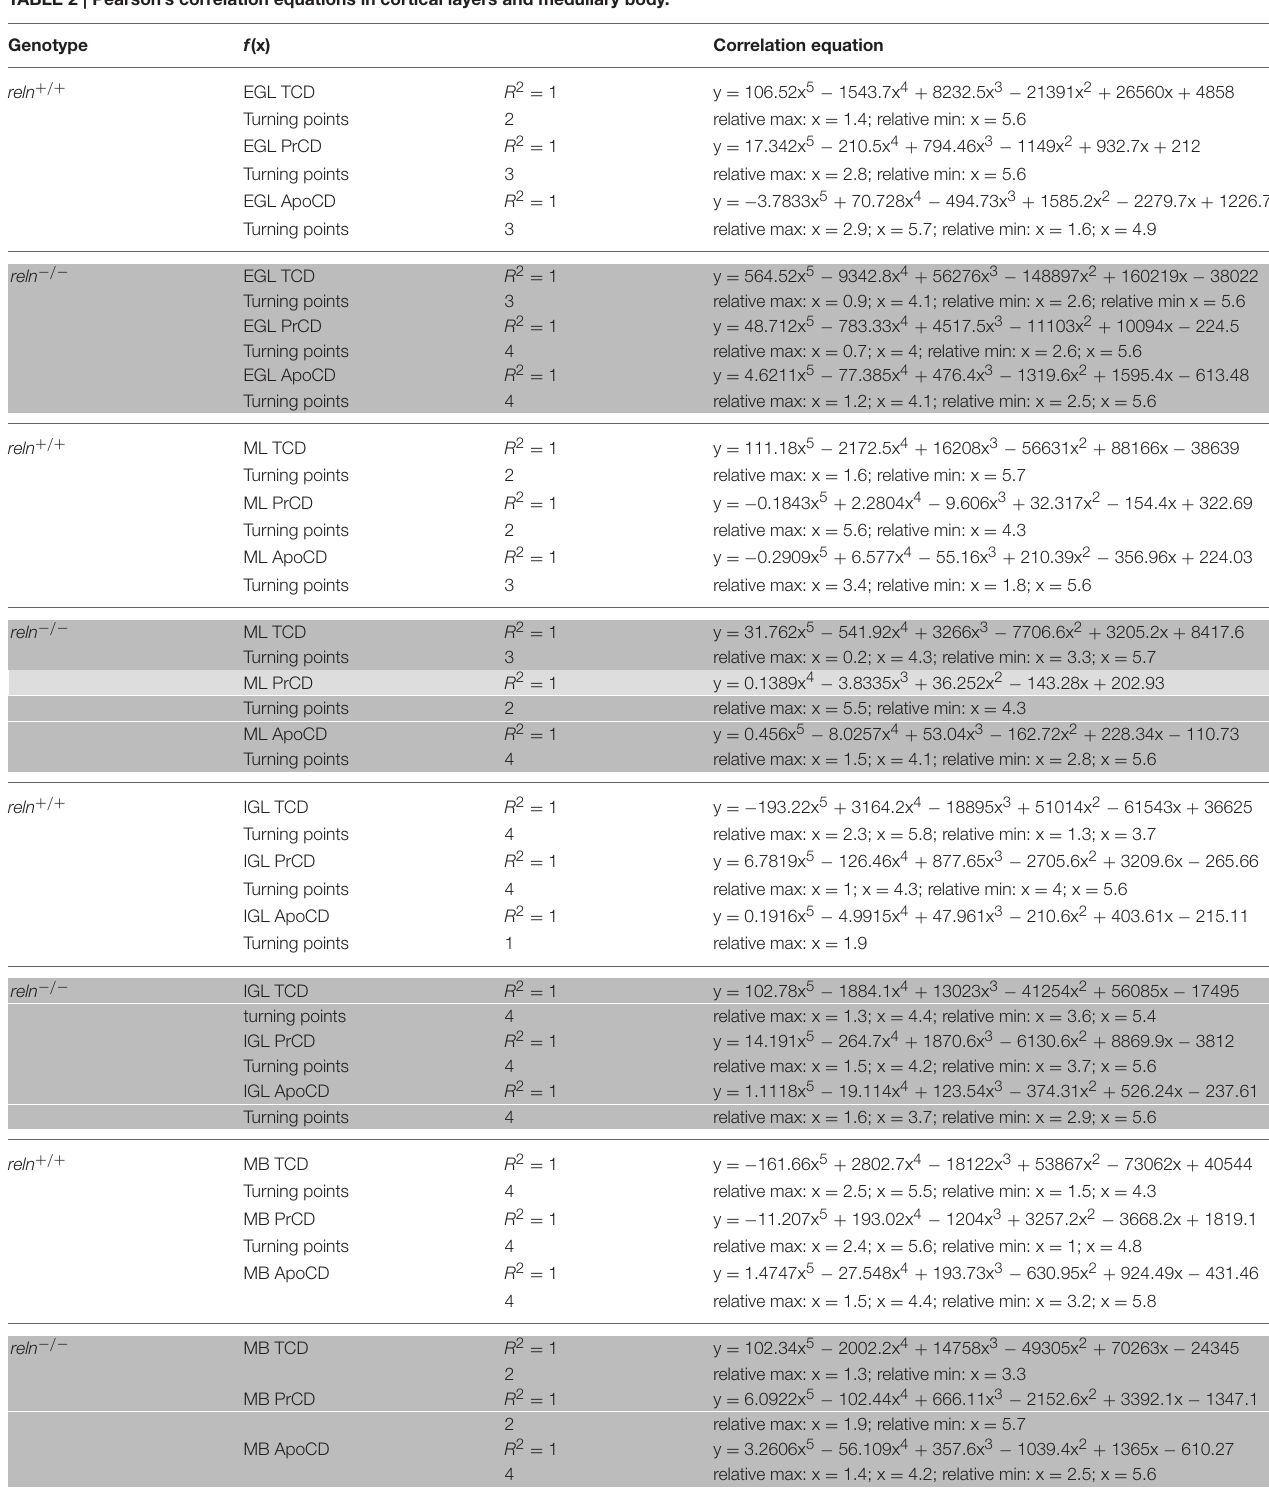
TABLE 2 | Pearson’s correlation equations in cortical layers and medullary body.